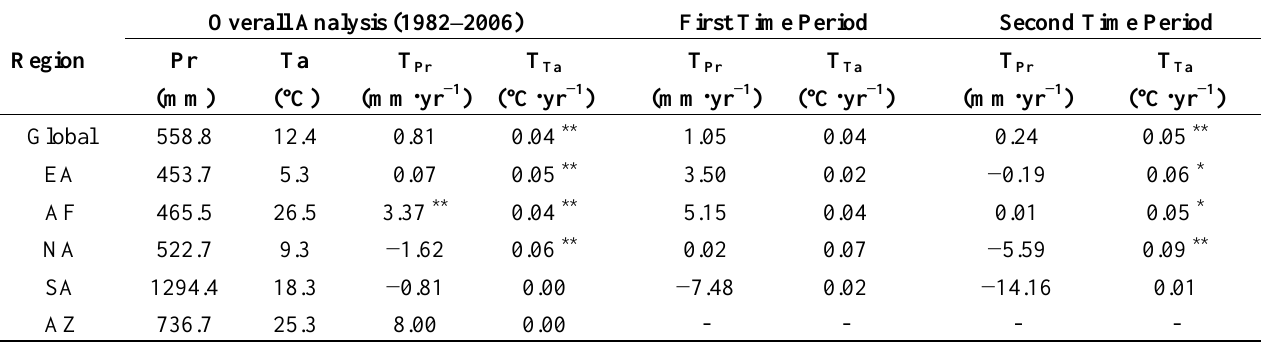
temperature, respectively. First and second time period refers to the time period before and after the turning point,